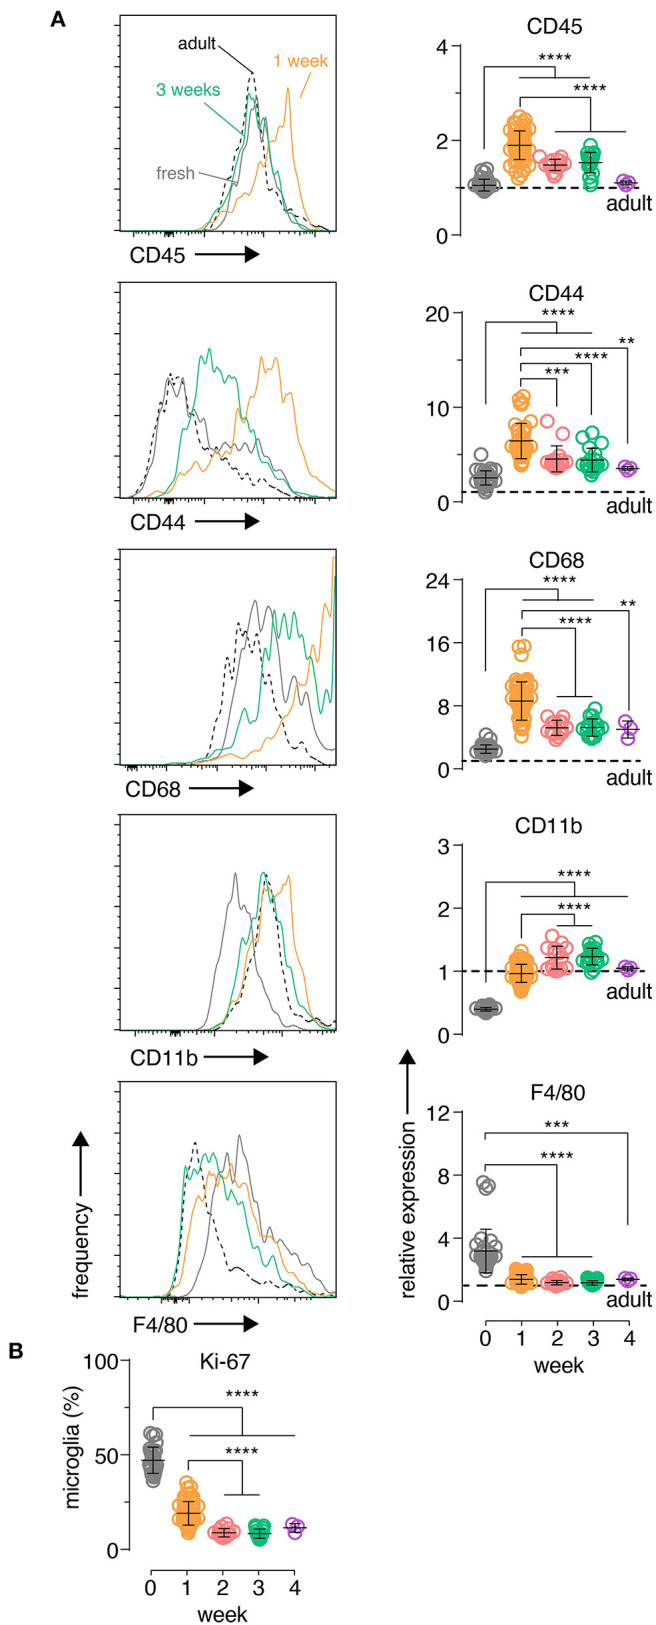
Organotypic brain slice microglia express inflammatory markers at early culture timepoints which then subside after 2 weeks. Organotypic coronal brain slice cultures were prepared from neonatal mice and cultured in vitro on a supporting membrane. (A) Changes in slice microglia phenotype at 1 week (orange histogram) and 3 weeks (green histogram) compared to fresh uncultured slice microglia (solid gray histogram) and acutely-isolated adult microglia (dashed black histogram) was determined based on the expression of the indicated markers by flow cytometry. Data is quantitated relative to levels in adult ex vivo microglia (denoted by the black horizontal dashed line). (B) Percentage of Ki-67+ microglia over time for the indicated timepoints. (A,B)
n = 4–59 slices. Pooled data from eight independent experiments. Each symbol represents microglia data from an individual slice, bars indicate mean ± SD. Representative FACS histograms shown, y-axis displays frequency relative to max. ****, *** and ** denote adjusted p-value <0.0001, 0.001 and 0.01, respectively by one-way ANOVA. See also Supplementary Figure 3.